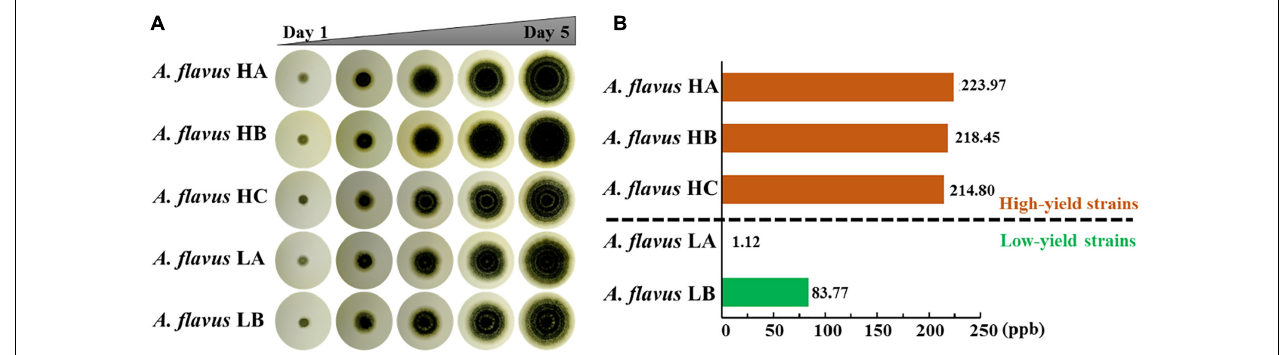
FIGURE 1 | Analysis of the clone phenotype and aflatoxin production in five different A. flavus strains. (A) The clone phenotype of five different A. flavus strains. Colonies of the A. flavus HA, HB, HC, LA, and LB strains were cultured in PDA medium for 5 days. (B) High-performance liquid chromatography analysis of aflatoxin production in the five different A. flavus strains, which were cultured in PDB medium at 28 ◦ C for 5 days. The orange and green bars indicate the high- and low-aflatoxin-yield A. flavus strains, respectively. Each assay was performed in three biological